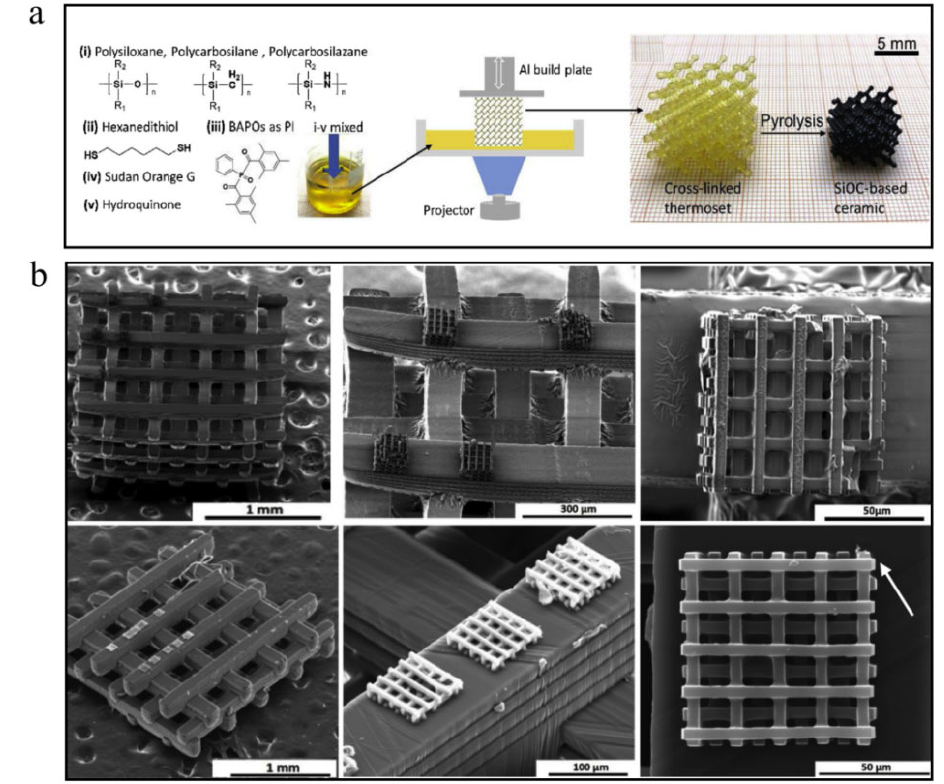
Fig. 28 DLP of polymer-derived SiOC ceramics: (a) Porous SiOC structure. Reproduced with permission from Ref. [82], © Elsevier B.V. 2019. (b) Micron and mesoscale SiOC structures. Reproduced with permission from Ref. [83], © Elsevier B.V. 2019.